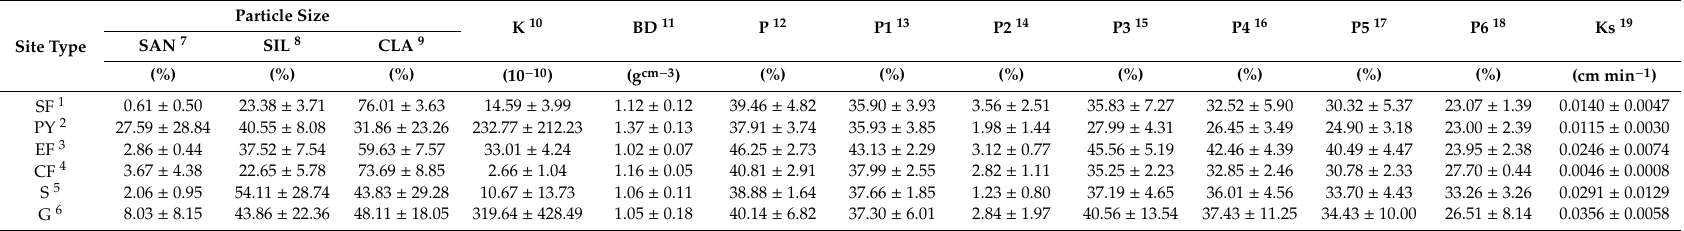
Table 1. Physical and hydrological properties of soil (average value ± standard